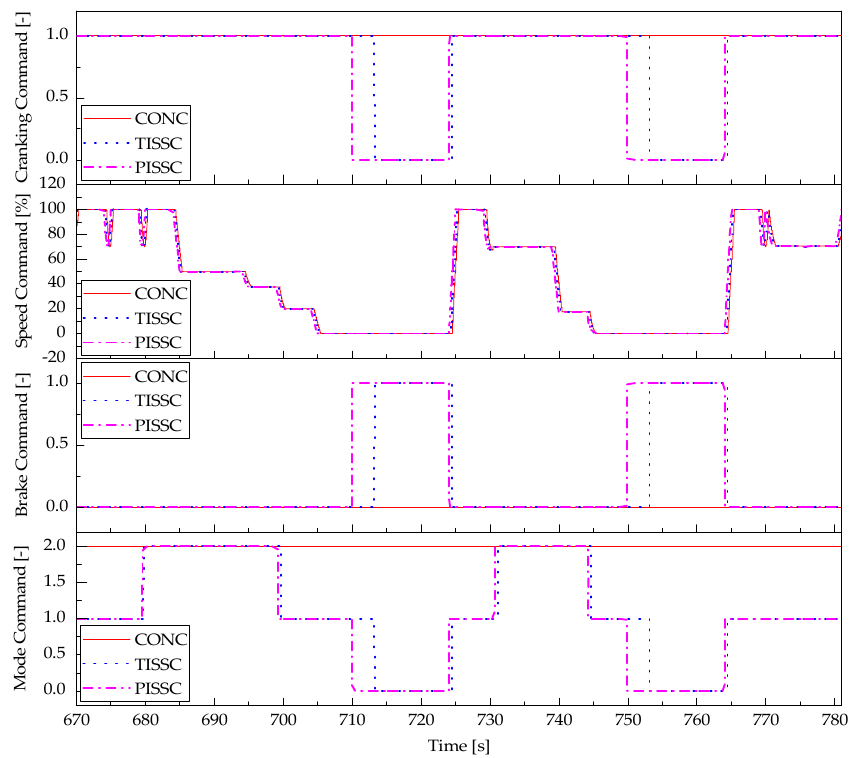
Figure 16. Comparison of HIL-ICE control inputs using difference controllers during cycle 7th.